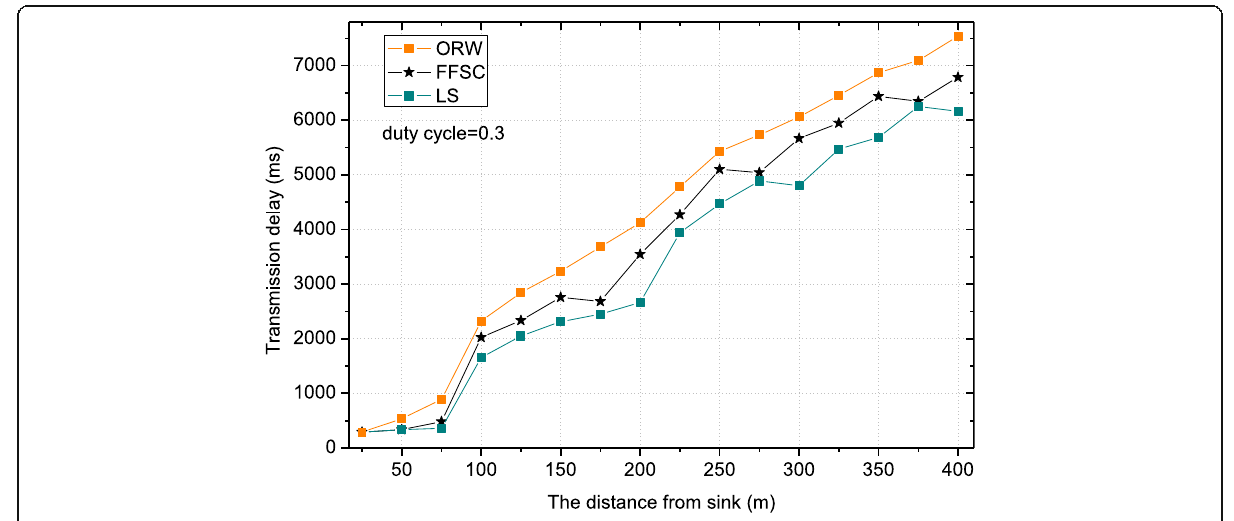
Fig. 20 The total delay under different distance from sink